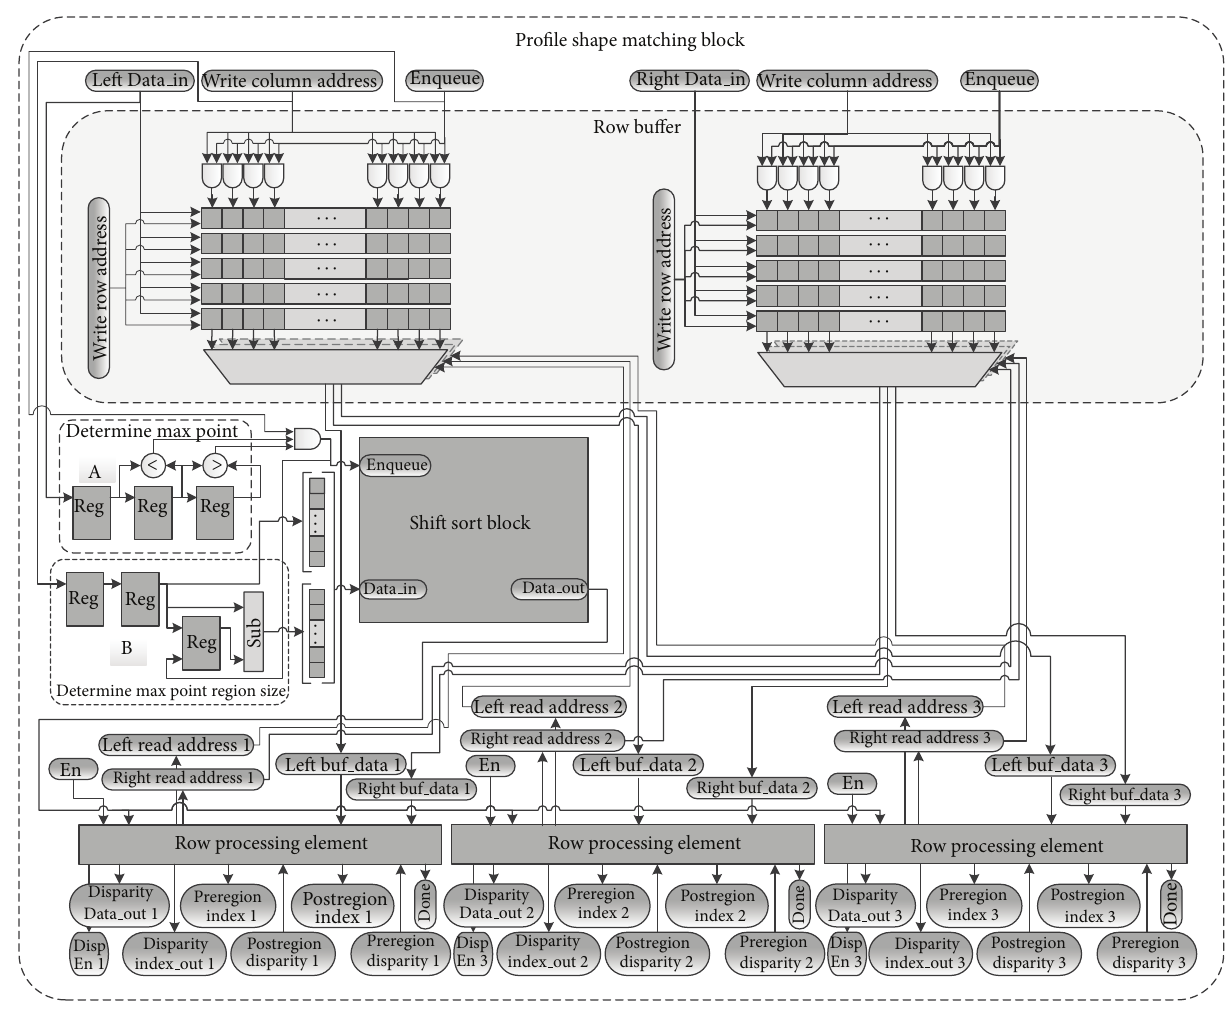
Figure 4: Profile shape matching hardware block diagram. Table 3: Accuracy, runtime performance, and hardware resource usage of FPGA implementation of the census-based algorithm by Jin et al. [18] and the profile shape matching